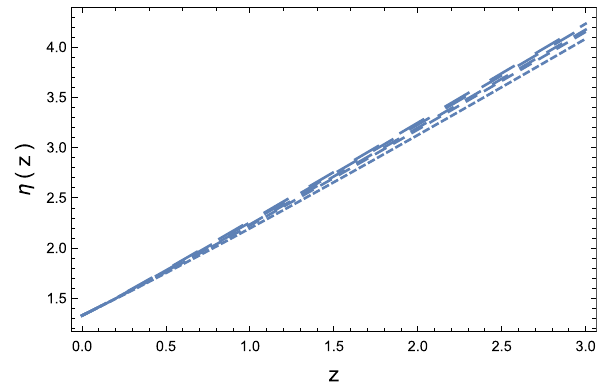
Fig. 7 Variation in the function η( z ) = ( 1 + z )( 1 + f ( z )) as a function of the redshift z in the Barthel–Kropina-FLRW dark energy model for different values of the parameter w of the dark energy equation of state: w = 1 . 45 (short dashed curve), w = 1 . 85 (dashed curve), w = 2 . 05 (longdashedcurve), w = 2 . 55(ultra-longdashedcurve),and w = 3 . 05 (ultra-ultra-long dashed curve), respectively. The initialconditions used tonumericallyintegratethesystemofcosmologicalevolutionequations are f ( 0 ) = 0 . 33, u ( 0 ) = 0 . 51, and h ( 0 ) = 1,